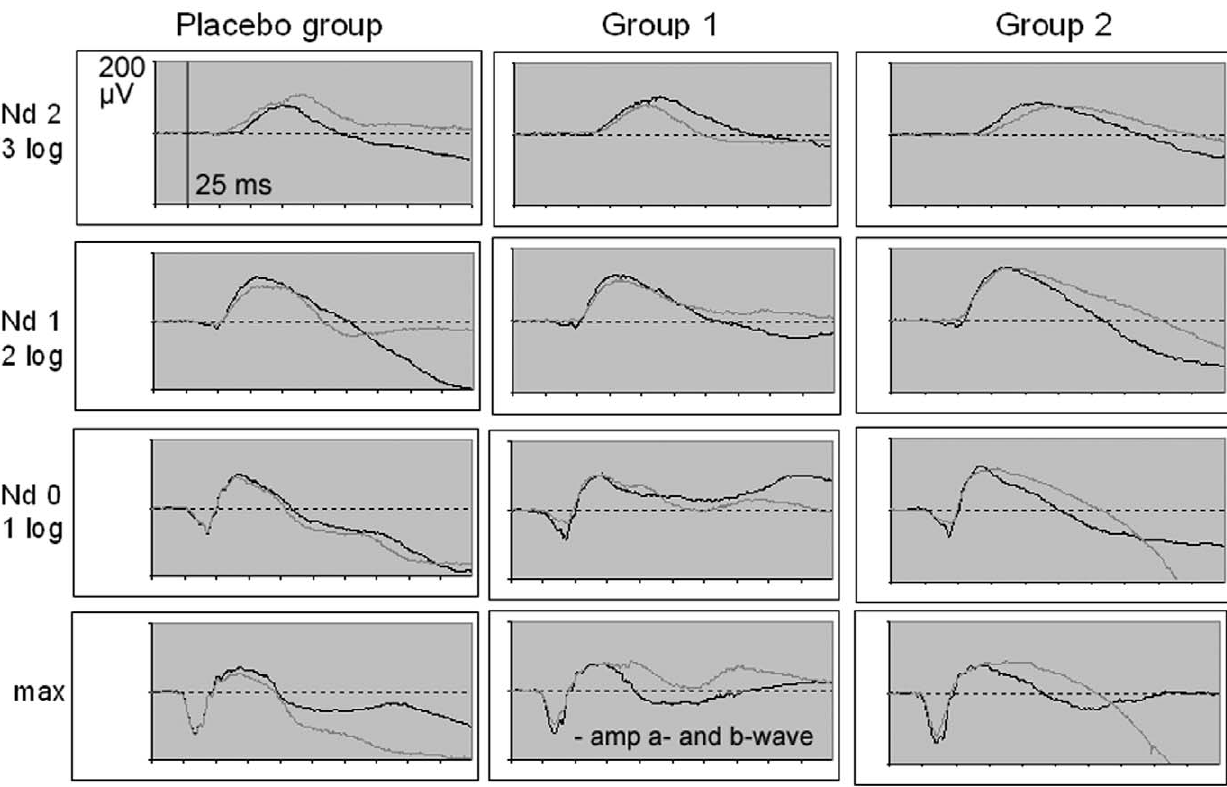
Figure 4. Mean dark adapted full-field ERG. Recordings for each group and flash strength at baseline (black line) and 4 hours after treatment (gray line). The effect of ZK200775 was subtle but recognizable. Statistically significant amplitude reduction of the a- and b-wave occured in the low dose group after 4 hours. doi:10.1371/journal.pone.0012111.g004 PLoS ONE |